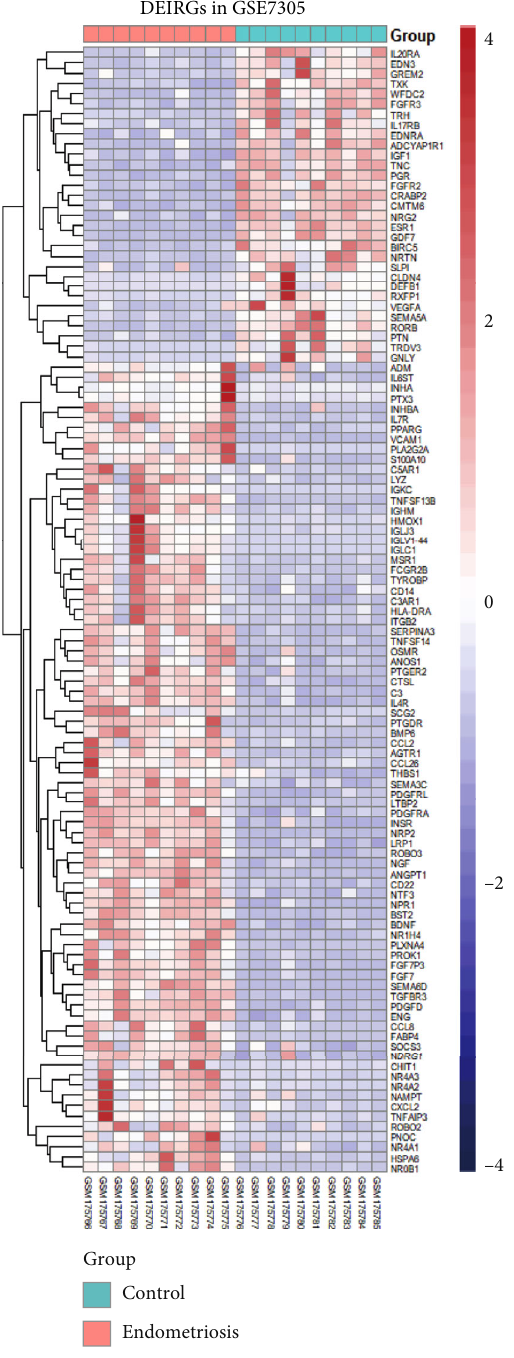
Figure 6: The heatmap of 111 DEIRGs in GSE7307. Each row represents an